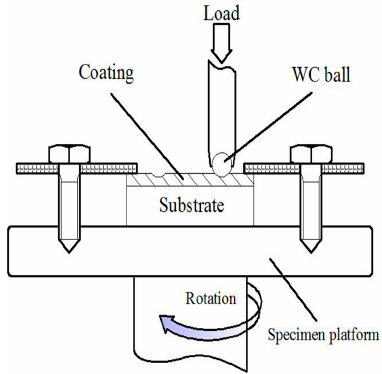
Figure 2. The schematic diagram of the wear test.